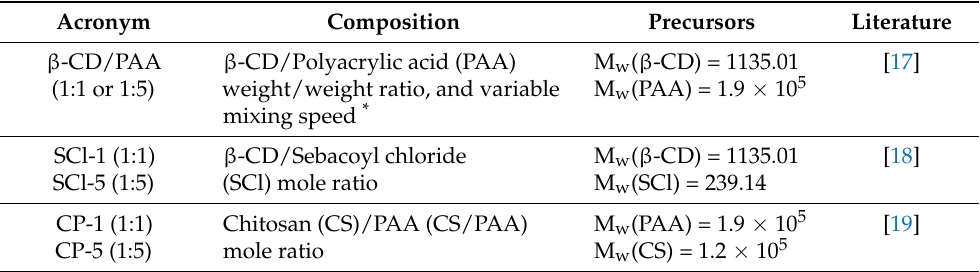
Table 3. Summary of copolymer adsorbent materials according to their synthetic composition and acronym